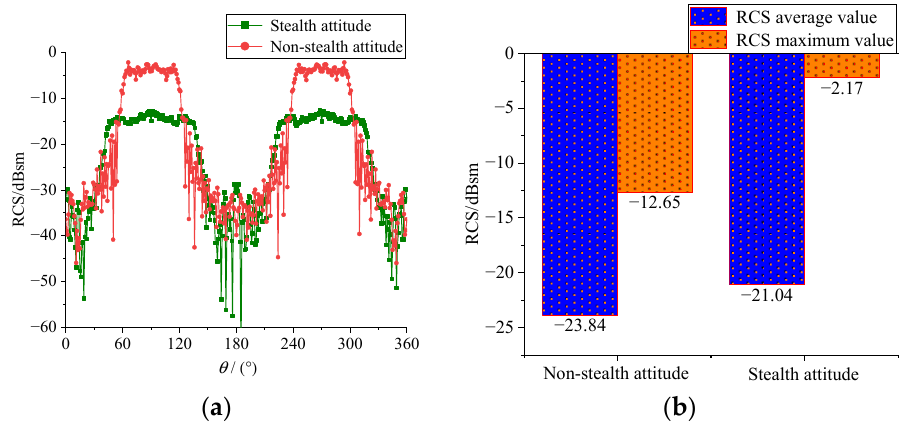
Figure 4. Comparison of RCS in different attitudes of the Olive-A configuration. ( a ) Comparison of